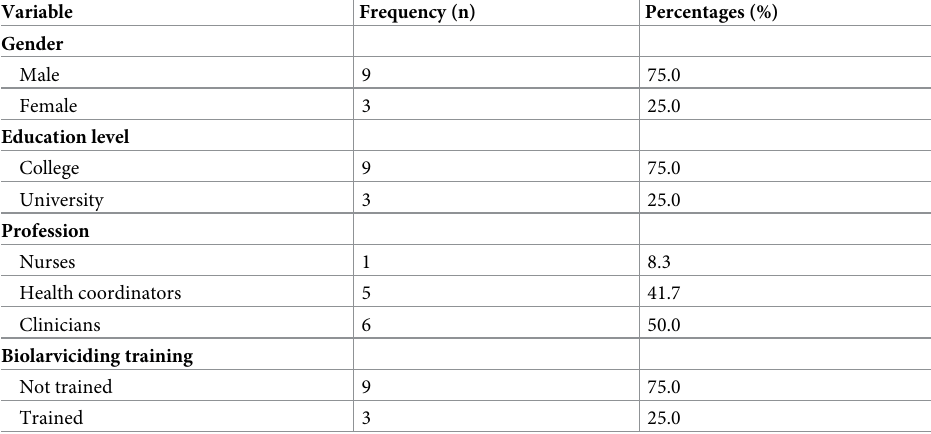
Table 2. Socio-demographic characteristics of vector control coordinators (n = 12).